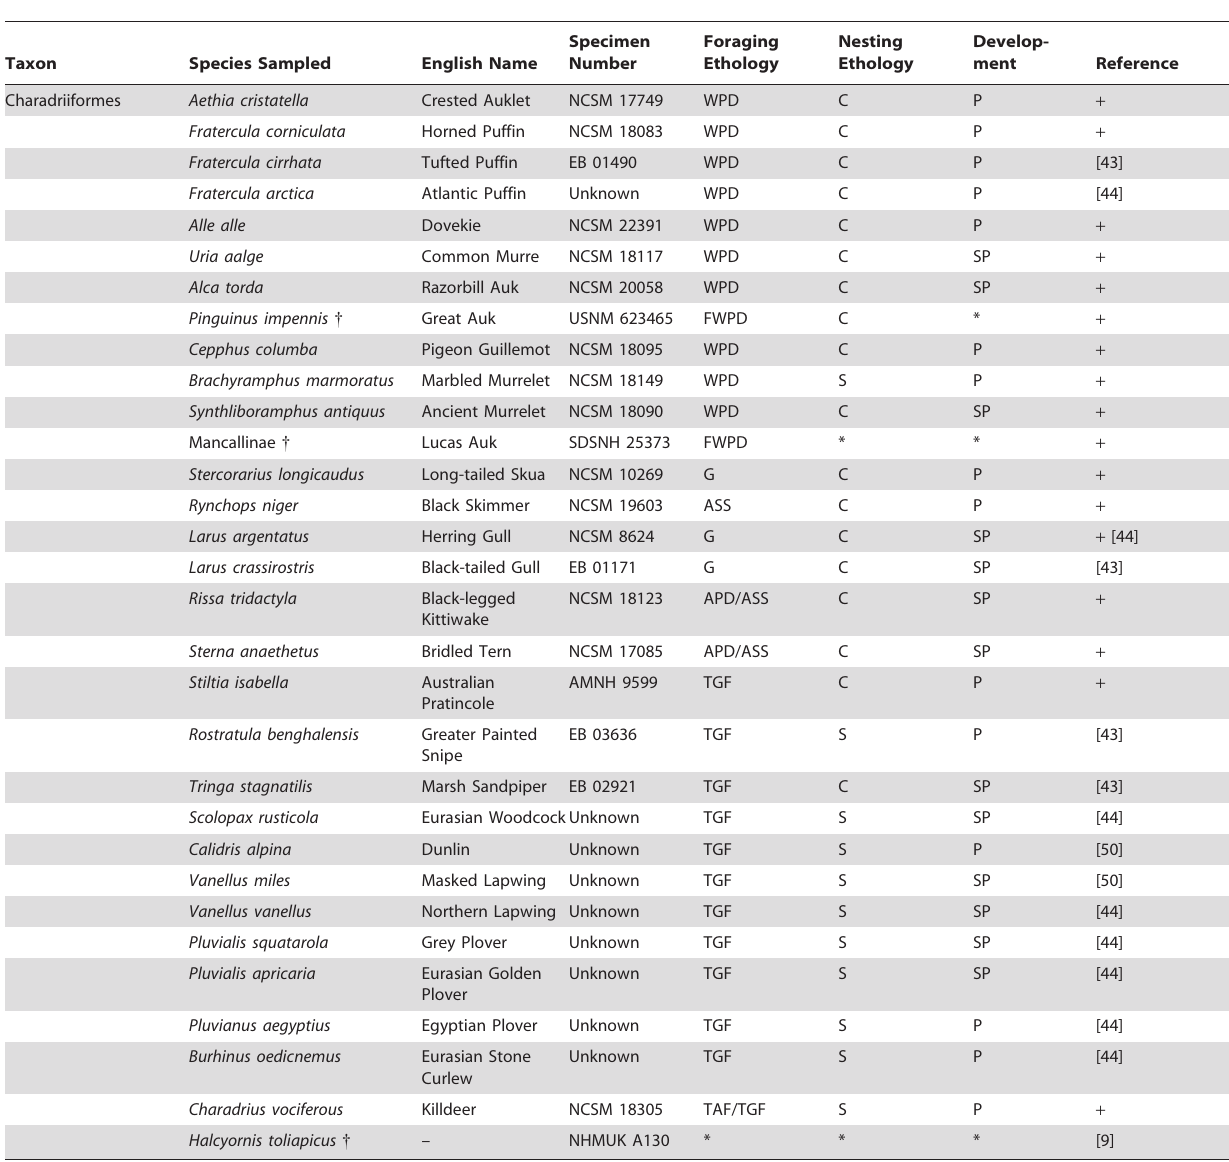
Table 1. Foraging behavior, nesting dispersion, and developmental strategies of sampled charadriiform taxa.